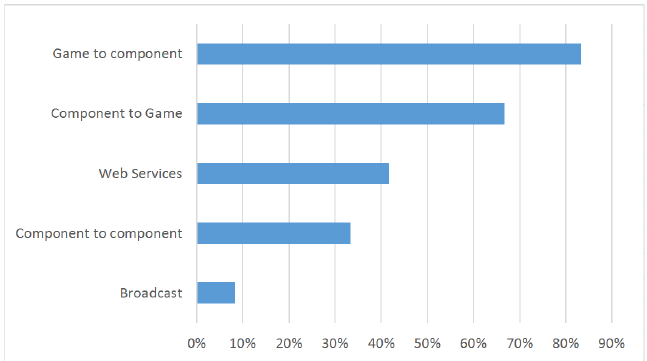
Fig. 1. Usage of software communication modes in client-side